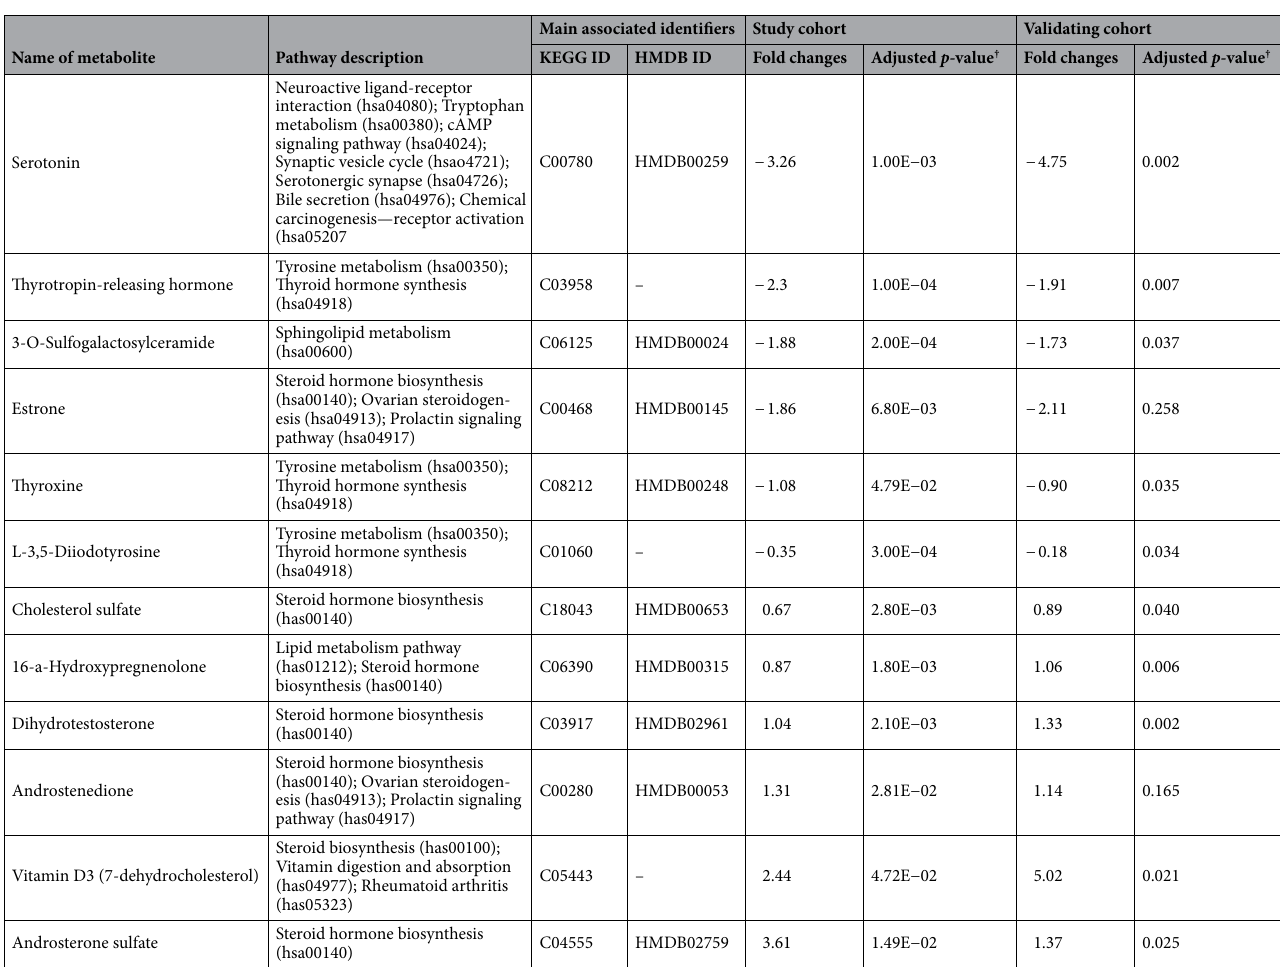
Table 2. The most significantly altered metabolites (estimated as fold-changes; 1 < log 2 FC < (− 1) in logarithmic scale, p -value cut-off p < 0.05) associated with proteins observed and measured in proteome layer in the